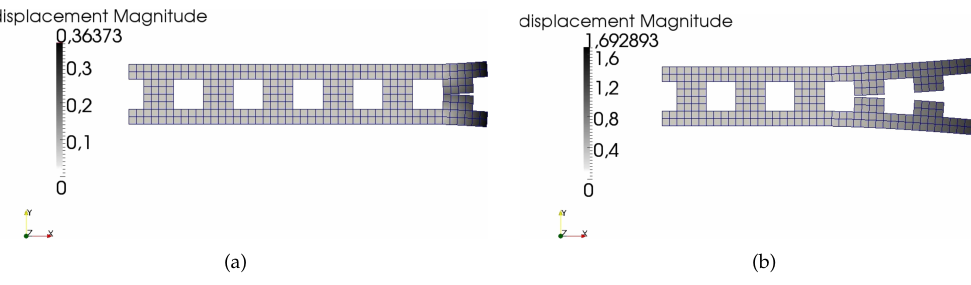
Figure 16. Deformed configuration at the end of the analysis by using: ( a ) geometric constraint, ( b ) hybrid constraint.